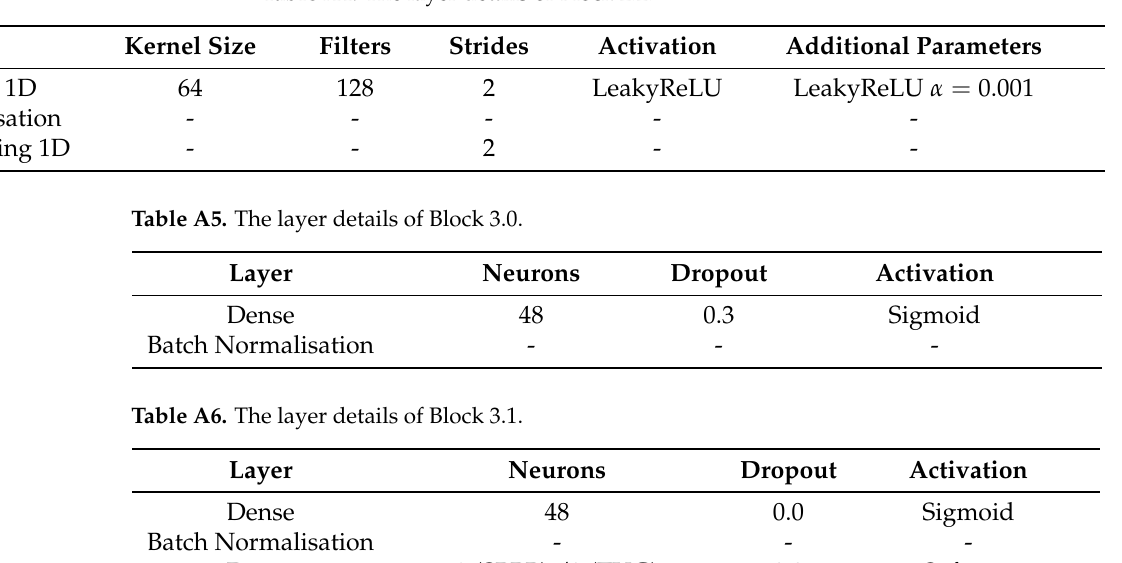
Table A4. The layer details of Block 2.2.